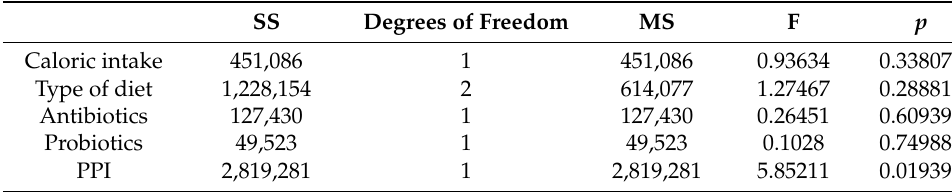
Table 4. Analysis of covariance ANCOVA for fecal calprotectin